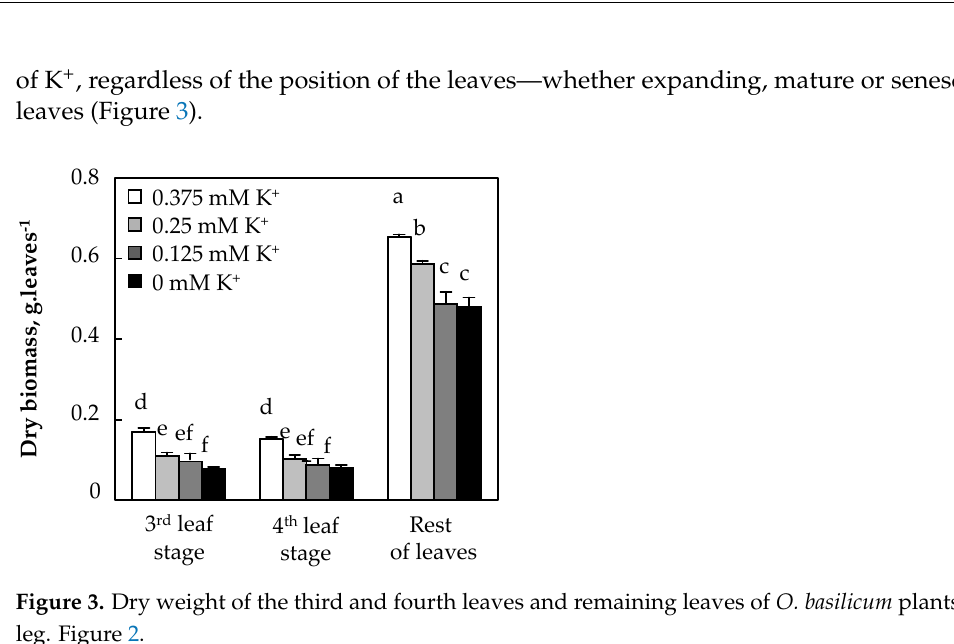
6 of 15 Figure 2. Dry weights of root, stem and all leaves of O. basilicum plants grown for 30 days in the presence of varying K + concentrations (0.375; 0.25; 0.125 and 0 mM). Means of eight replicates and confidence intervals at the 5% level are presented. Bars with the same letters as indicated in the